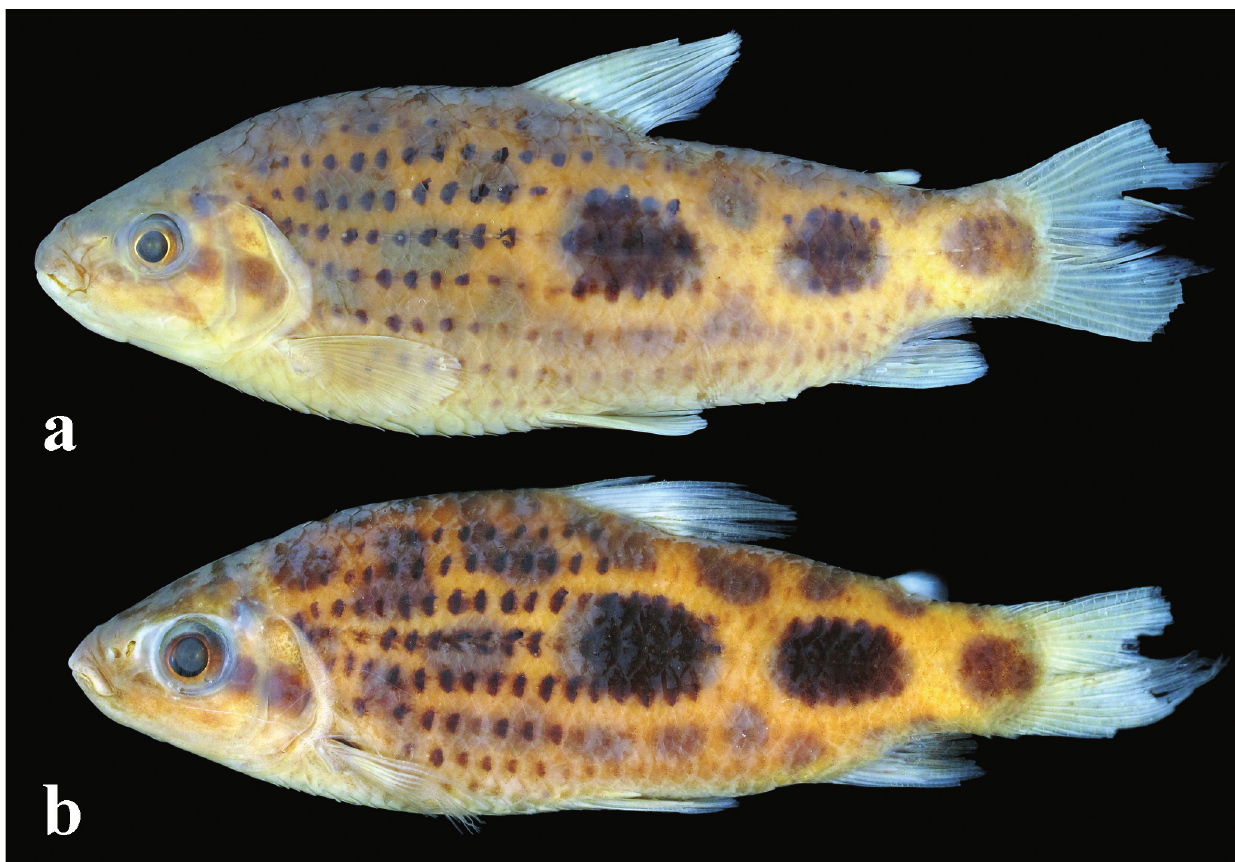
Fig. 1. Leporinus santosi : ( a ) holotype, MZUSP 110000, 117.5 mm SL, igarapé do Pojuca, tributary of rio Itacaiúnas, 5°22’S 50°32’W, Parauapebas, Pará, Brazil; ( b ) paratype, 29156, 61.6 mm SL, rio Itacaiúnas at cachoeira Carreira Comprida, 5°52’S 50°32’W, Parauapebas, Pará, Brazil.